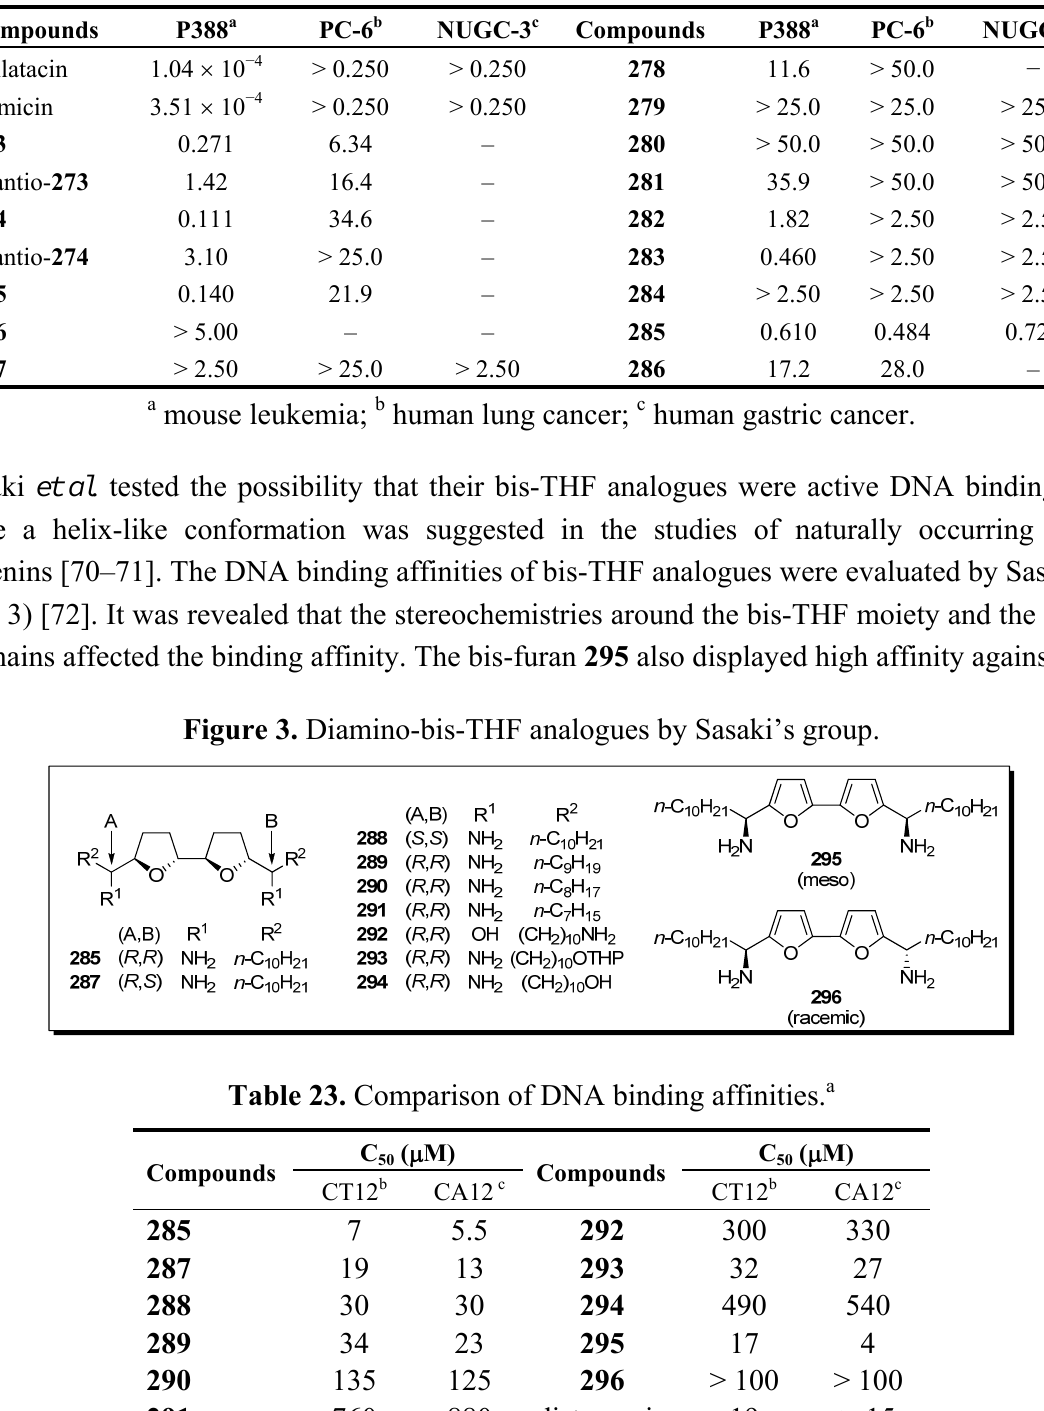
( μ M) values against cancer cell lines. Table 22. GI 50